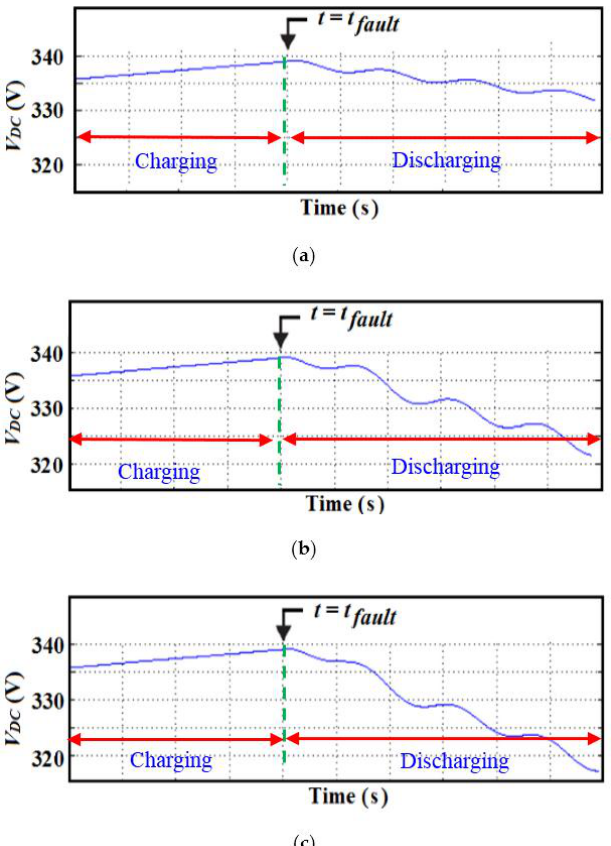
Figure 10. DC link voltage (V) when the grid experiences: ( a ) S-L-G; ( b ) S-L-L; and ( c ) D-L-G faults (X-axis: 0.1 s/div; Y-axis: 5 V/div).